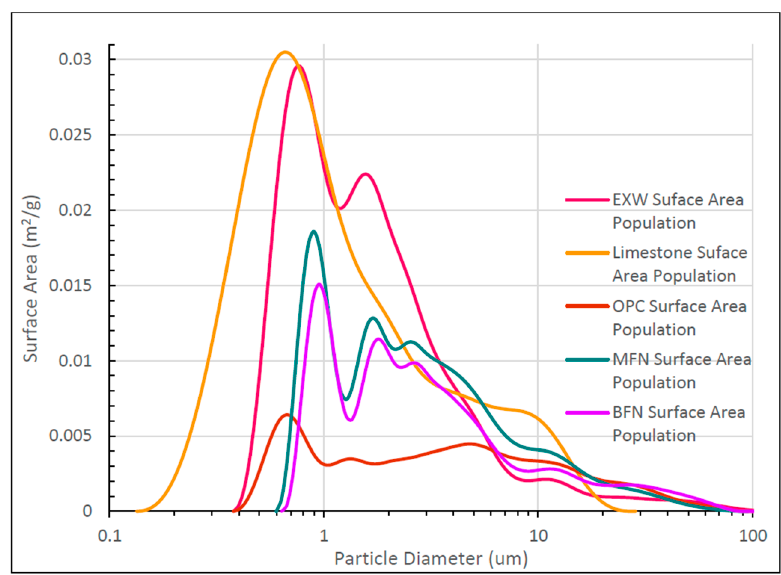
Figure A1. Specific surface area distribution of the three calcined clays, limestone and OPC.